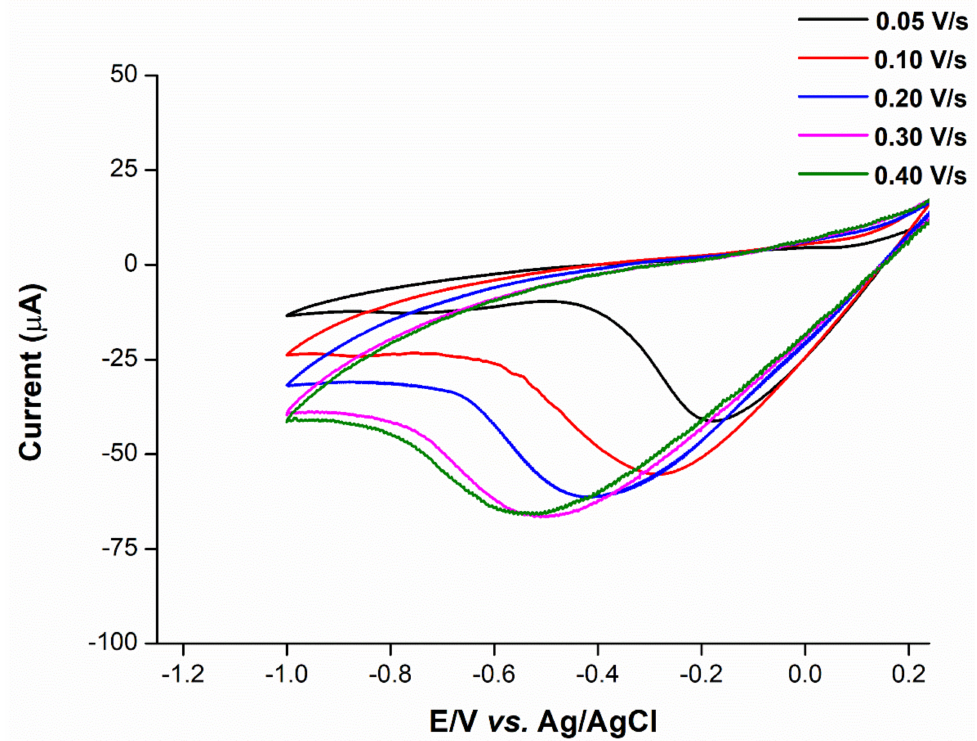
Figure 8. Voltammogram of the DOS:TOTM hybrid sensor in 125 ppm cadmium(II) and 0.1 mM HCl solution at different scan rates (0.05, 0.10, 0.20, 0.30 and 0.40